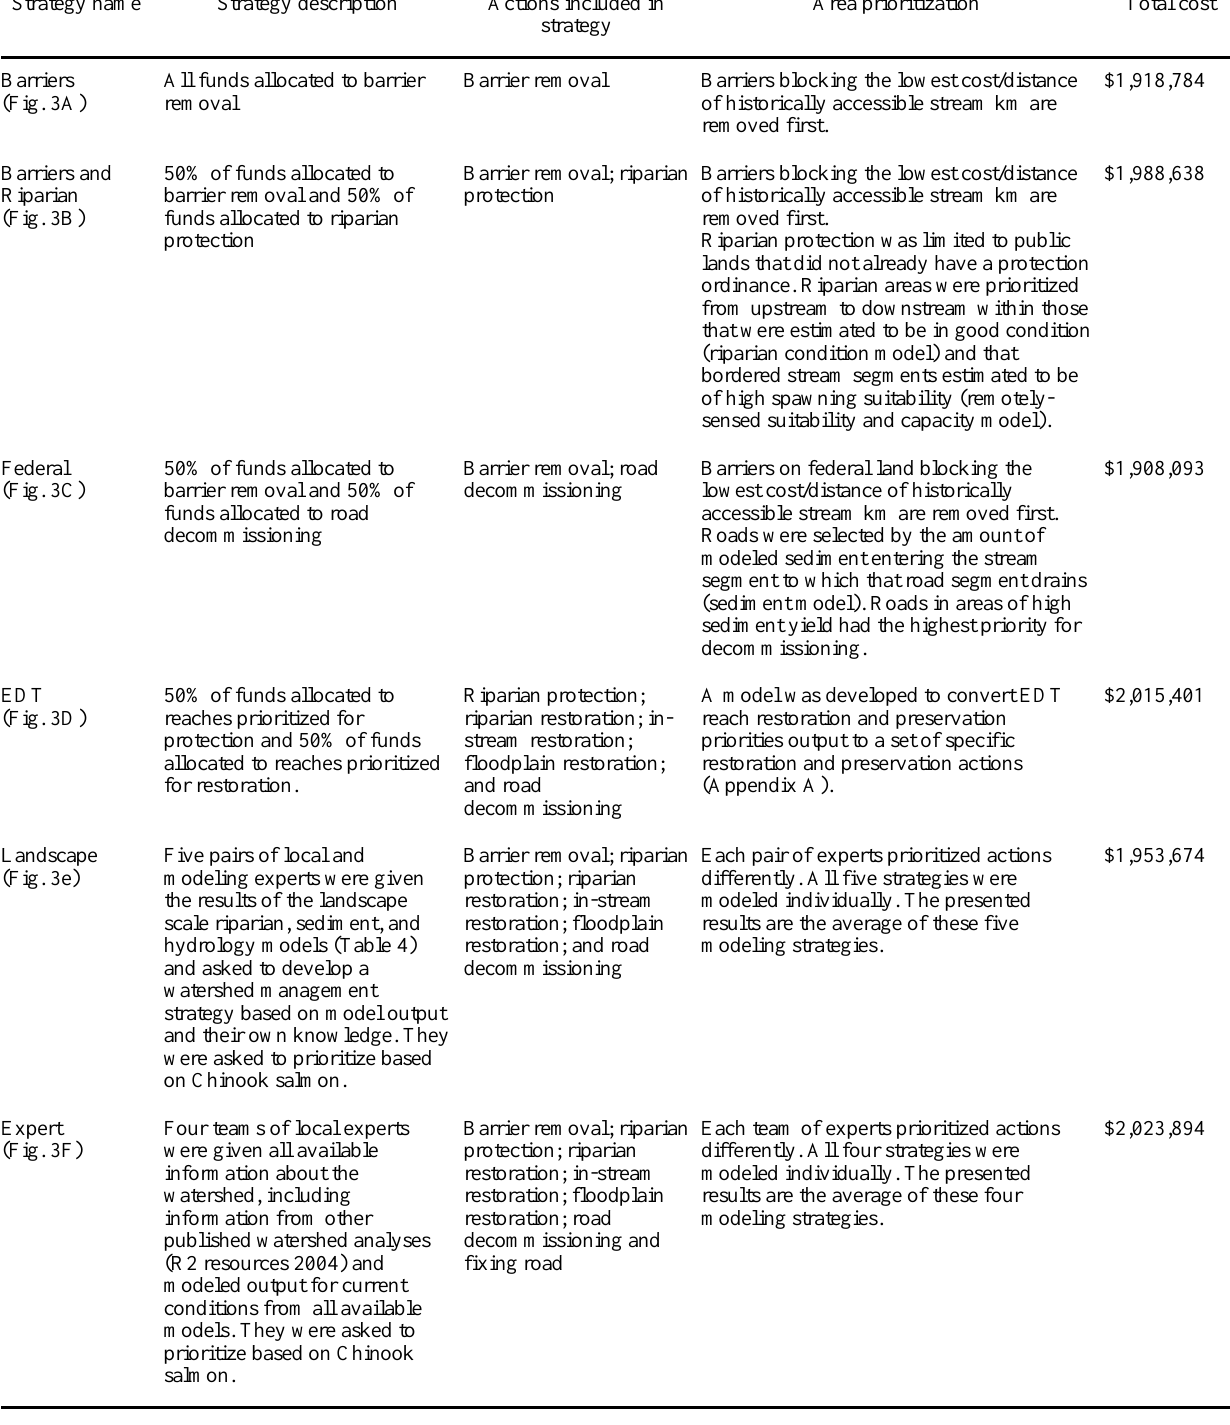
Table 2. Watershed management strategies. Note that barrier removal can describe either the physical removal of the barrier or modifying the barrier so that it is passable to